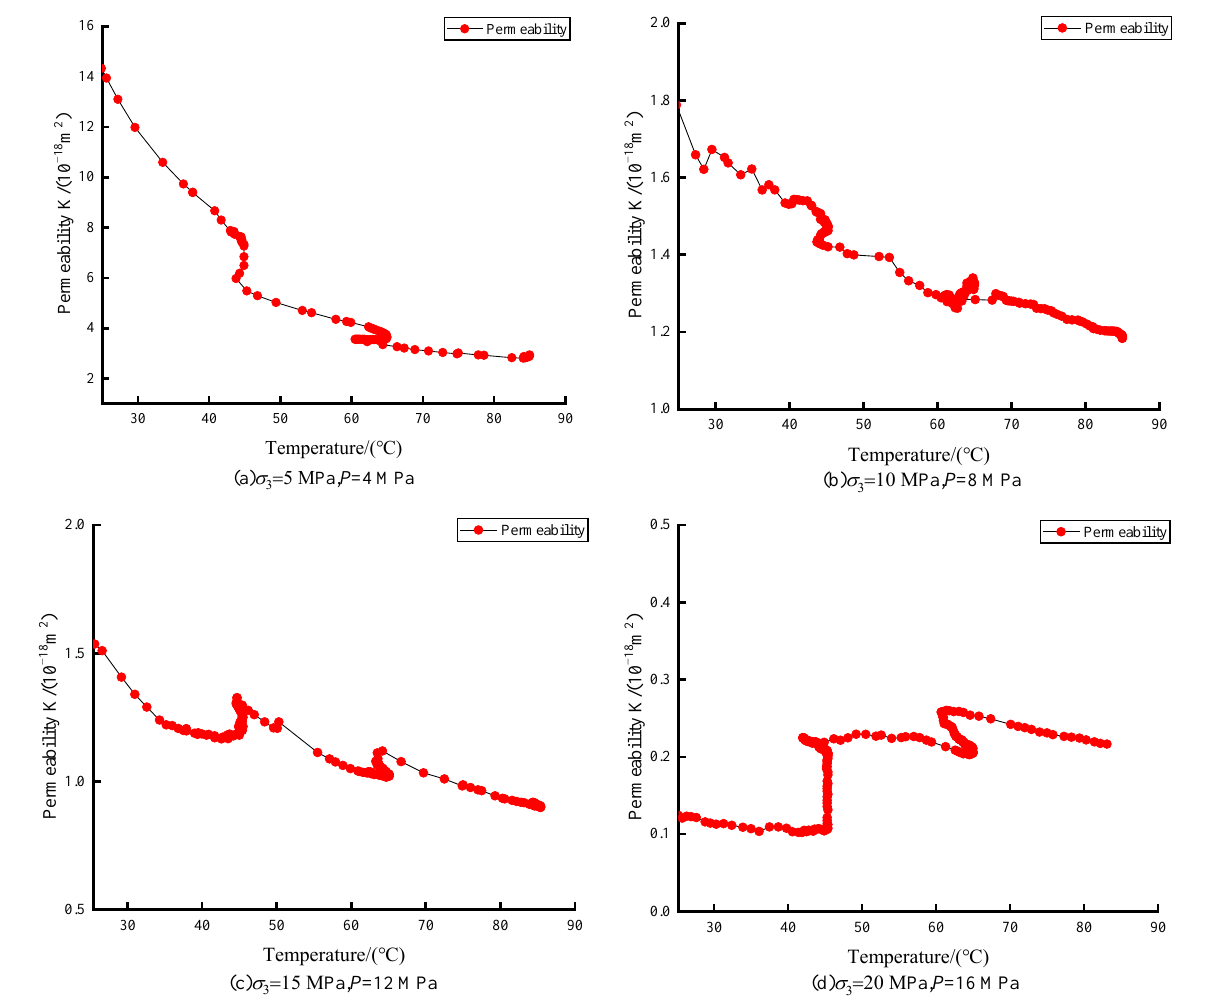
Figure 8. Curves of permeability change under different confining pressures. Table 2. Permeability increase of coal specimens at different